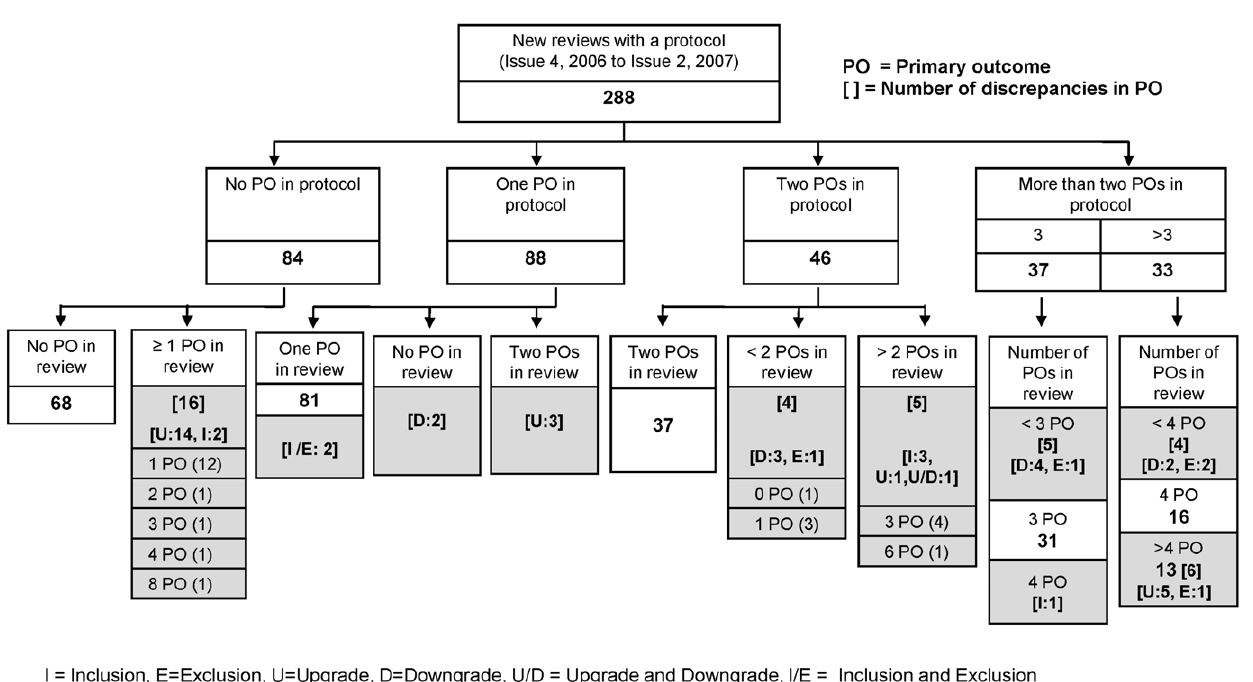
Figure 1. A flow diagram showing the discrepancies between protocol and review primary outcomes. The shaded areas indicate where the discrepancies were found.